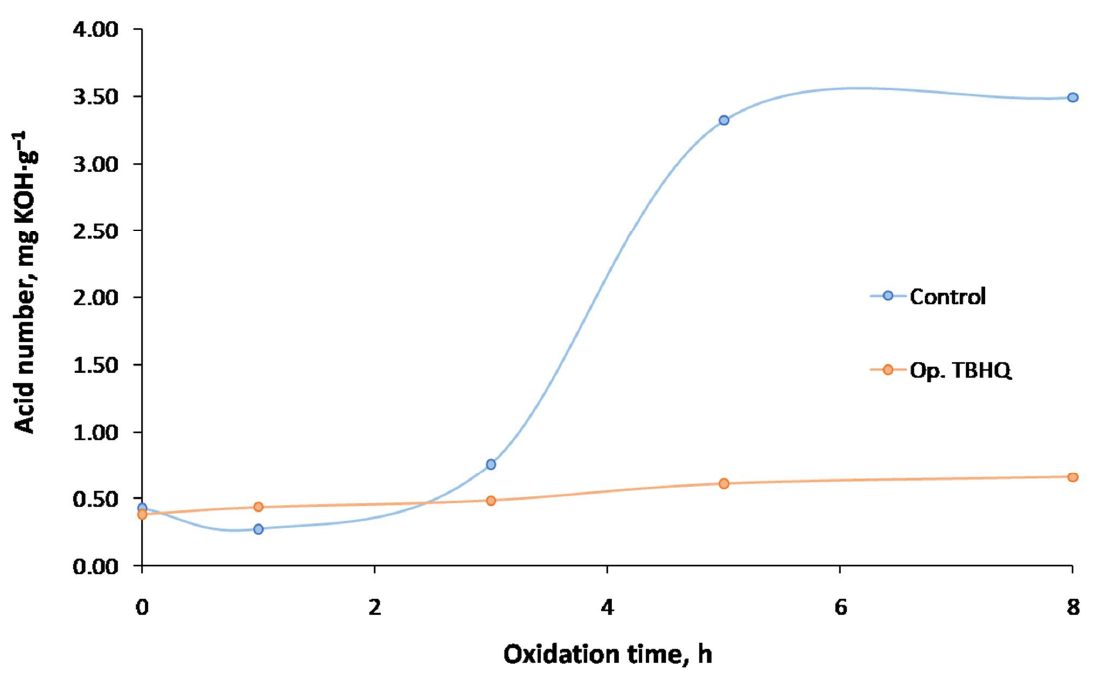
Figure 13. Effect of TBHQ addition on FOBL acid number during oxidation.